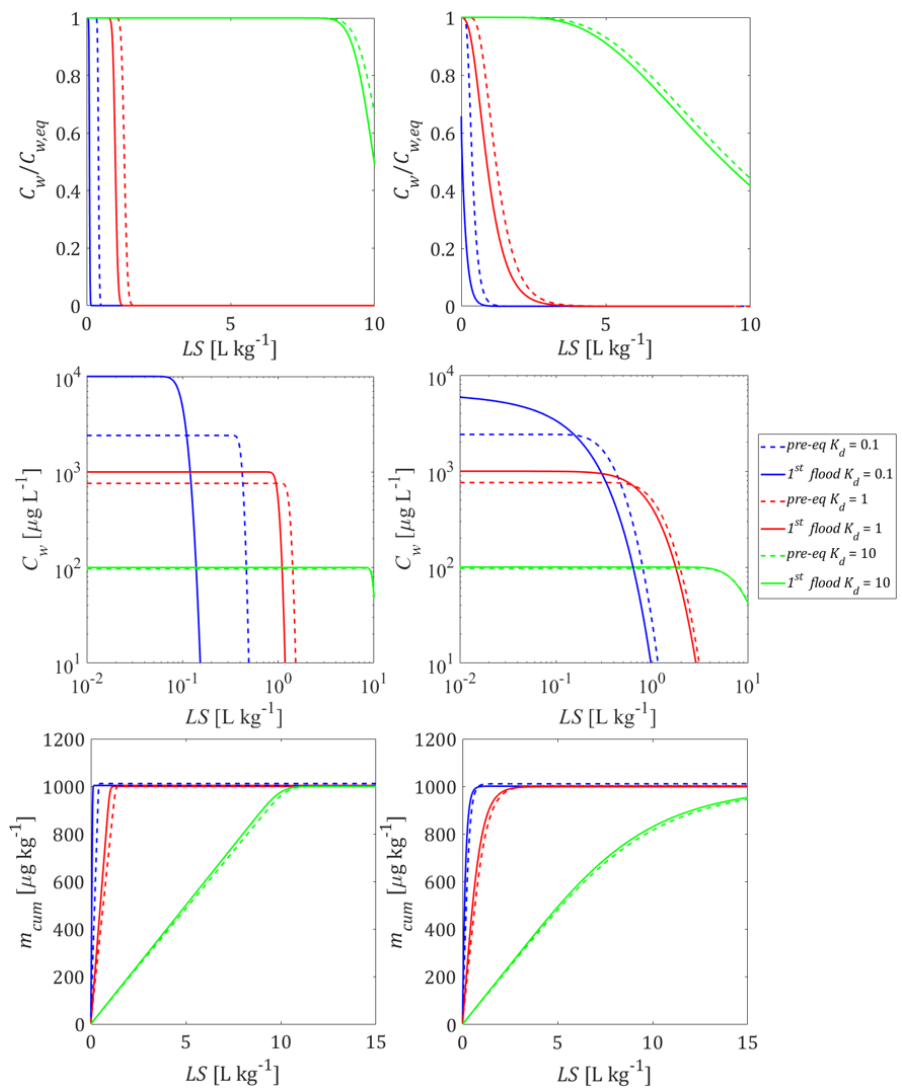
Figure 5. Normalized and absolute concentration ( C w / C w , eq , C w ) as well as cumulative concentration ( m cum ) in the column effluent vs. time (expressed as liquid to solid ratio: LS ) for the initial conditions (depicted in Figure 4) established after the first flooding of the column (solid lines) compared to the pre-equilibrated case (dashed lines). Left column : without dispersion; right column : with dispersion.